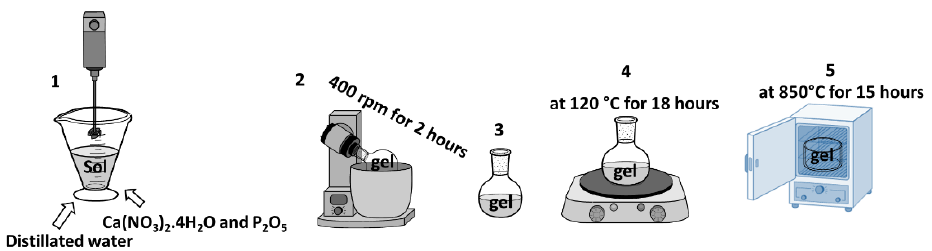
Figure 2. The synthesis route (Sol-gel method) of HA.